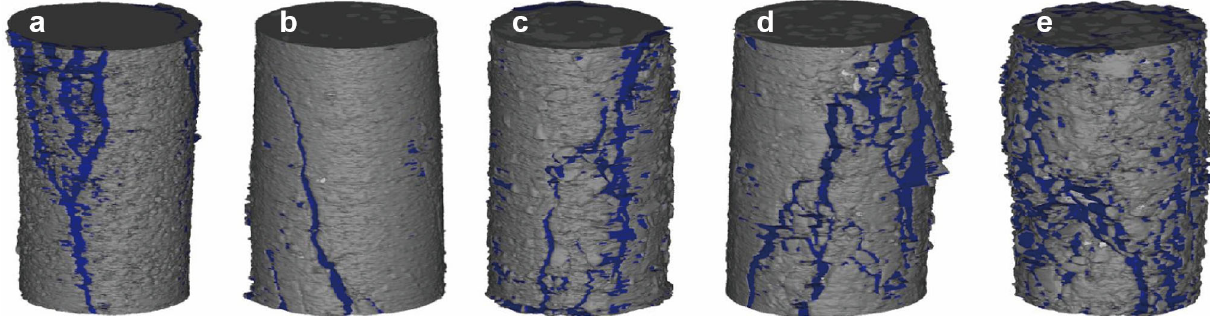
Fig. 14 Failure patterns of the prototype models acquired through CT scan (images a–e represent rock ratios of 0%, 10%, 20%, 30% and 50%, respectively), in which dark blue color indicates the fractures or cracks when